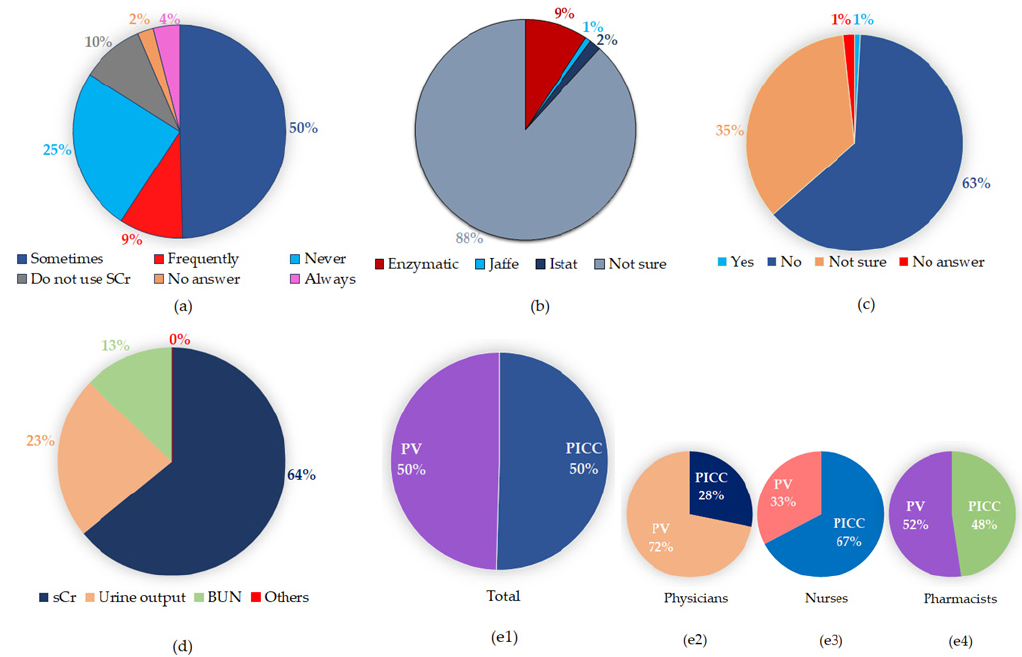
Figure 1. Survey findings. ( a ) Have you noticed erratic creatinine (Cr) results? ( b ) Which Cr assay is used in your main lab? ( c ) Are you aware of DD interference in E-sCr results? ( d ) What is the preferred means of monitoring renal function in critical care patients? ( e1 – e4 ) Preferred draw site in these patients. ( e1 ) Total; ( e2 ) physicians; ( e3 ) nurses; and ( e4 ) pharmacists. E-sCr: enzymatic serum creatinine; PV: peripheral vein; PICC: peripherally inserted central catheter.